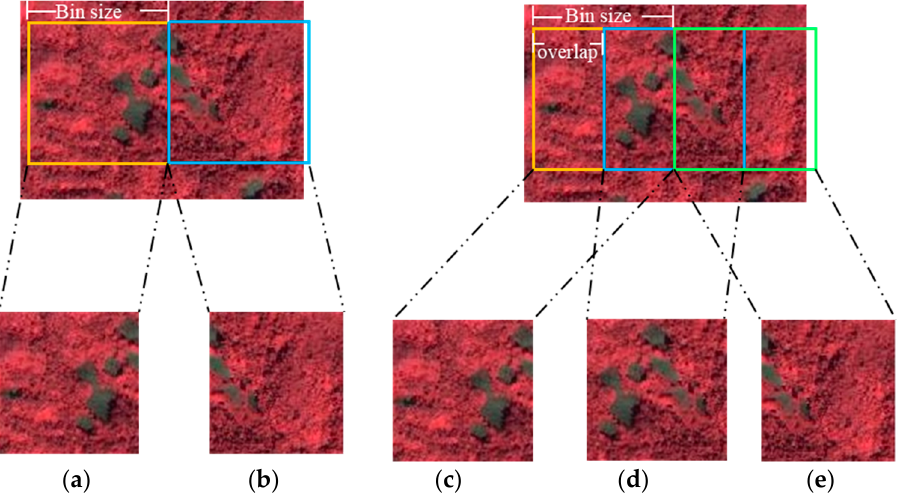
Figure 19. Images showing the benefit of using an overlap. ( a–b ) Poor samples when the target is at the edge of the image; ( c–e ) samples when set an appropriate value for the overlap, especially ( d ) retains the poppy parcel features.